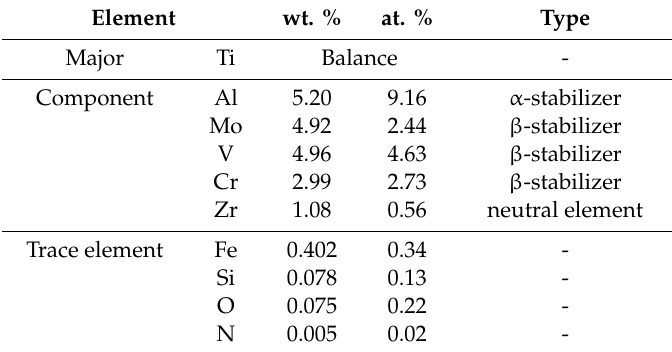
Table 1. Chemical composition of the as-received Ti-55531 alloy.